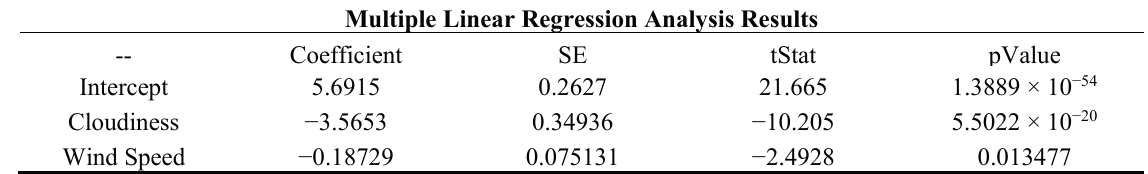
Figure 3. Average daily cloudiness, wind speed and T-diff relationship at CREST-SAFE for winters 2013 and 2014. Table 1 . Cloudiness, wind speed, and T-diff multiple linear regression analyses results for CREST-SAFE data for the winter of 2013 and 2014.